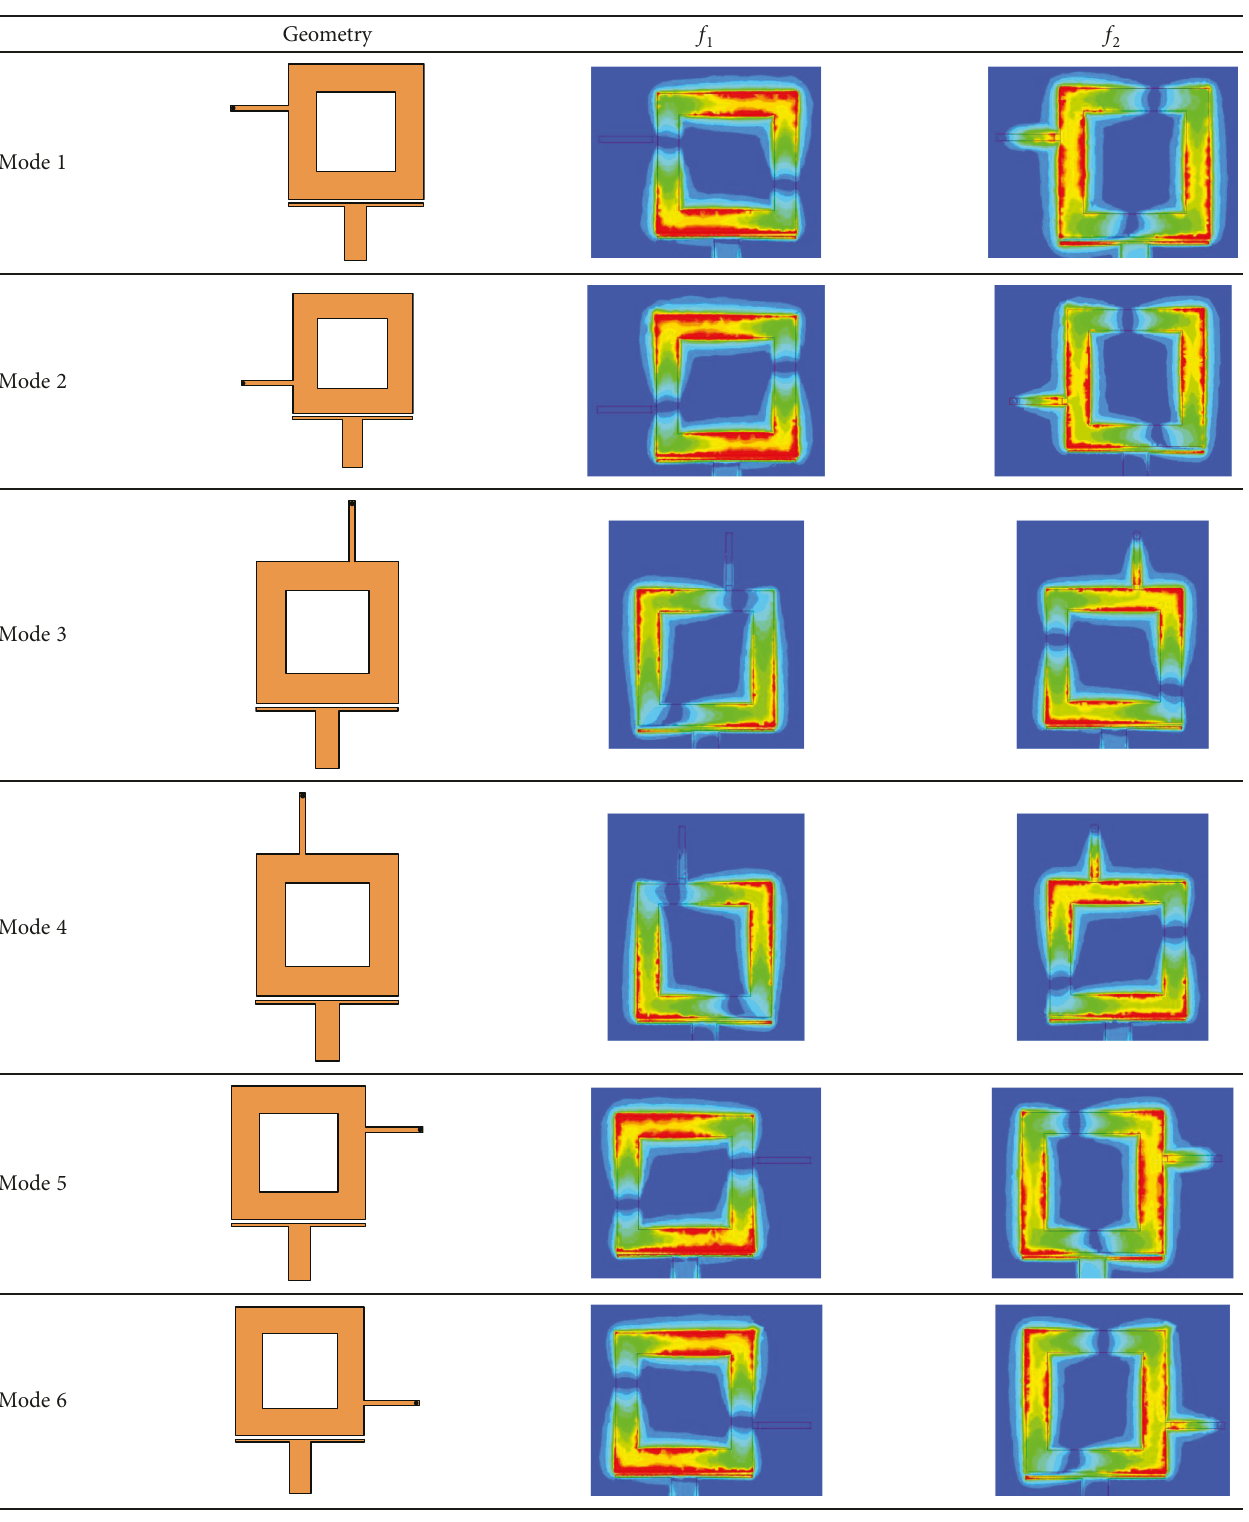
Table 1: Polarization of the square-ring antenna with di ff erent stub